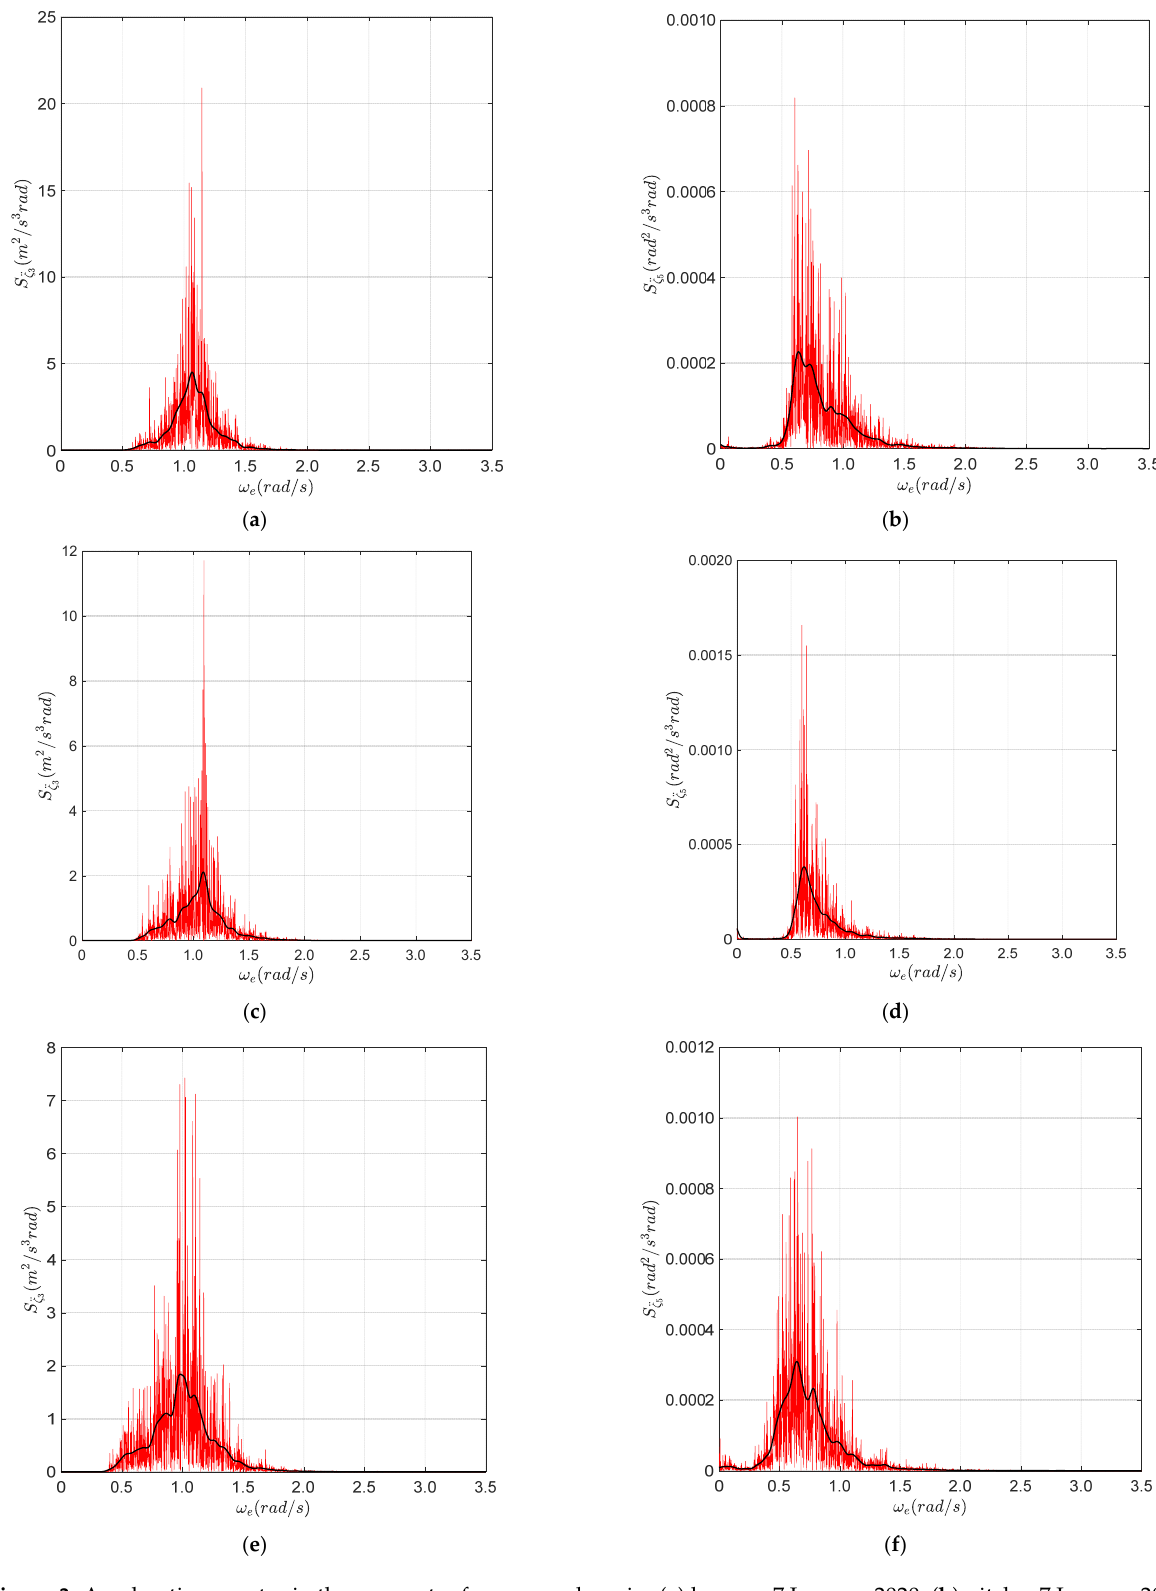
Figure 3. Acceleration spectra in the encounter frequency-domain: ( a ) heave—7 January 2020; ( b ) pitch—7 January 2020; ( c ) heave—8 January 2020; ( d ) pitch—8 January 2020; ( e ) heave—14 February 2020; ( f ) pitch—14 February 2020.